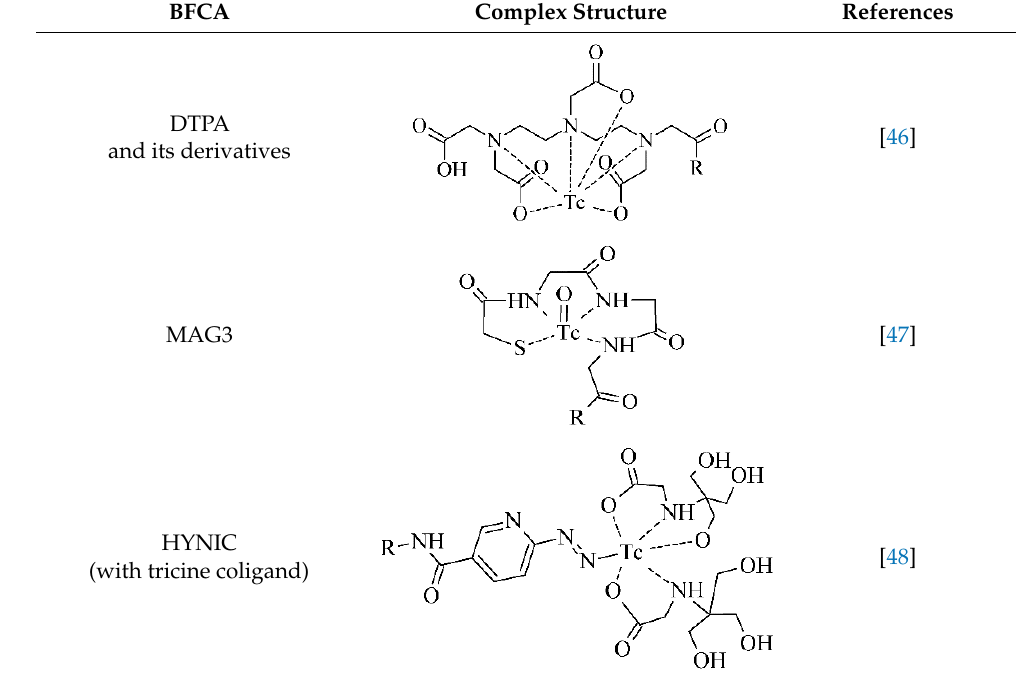
Table 2. The most common BFCA for 99m Tc-labeled compounds.